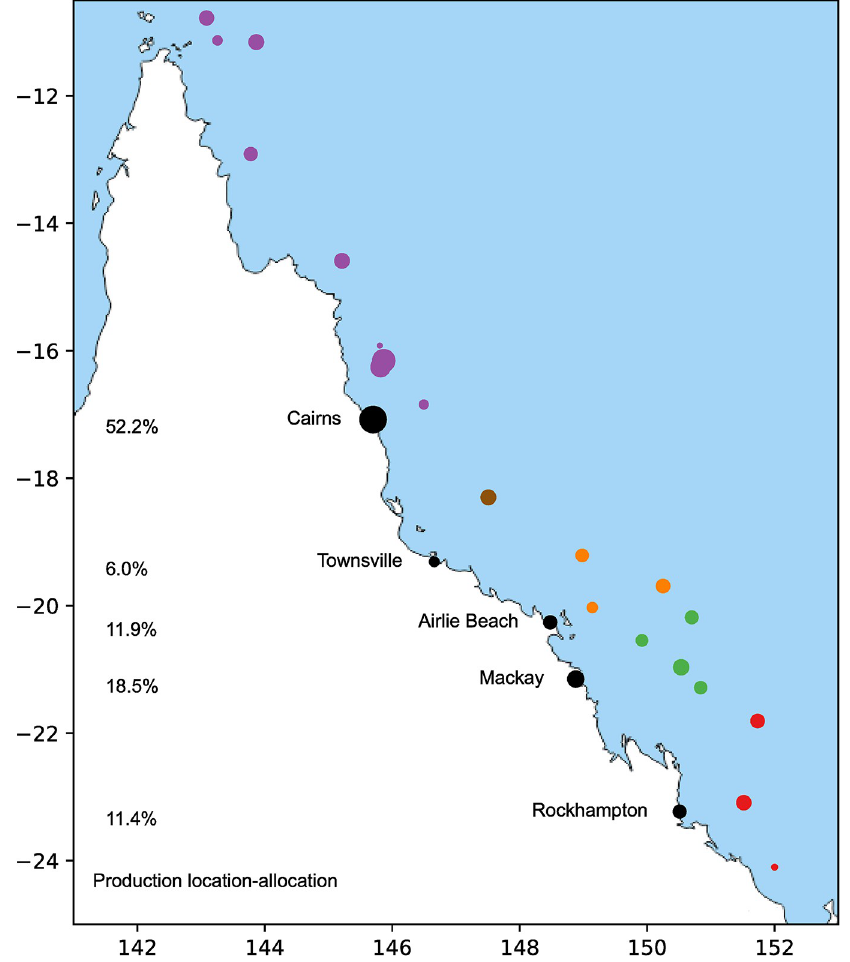
Fig 3. A spatial plot of optimal solution for parametrized base case. Reef clusters are sized by demand quantity and coloured by optimal port assignment–Cairns in purple, Townsville in brown, Airlie Beach in orange, Mackay in green, and Rockhampton in red. Optimal facility locations are coloured black sized by their production quantity, and indicated as proportion of total coral produced. Reprinted from [36] under a CC BY license, with permission from d- maps.com, original copyright